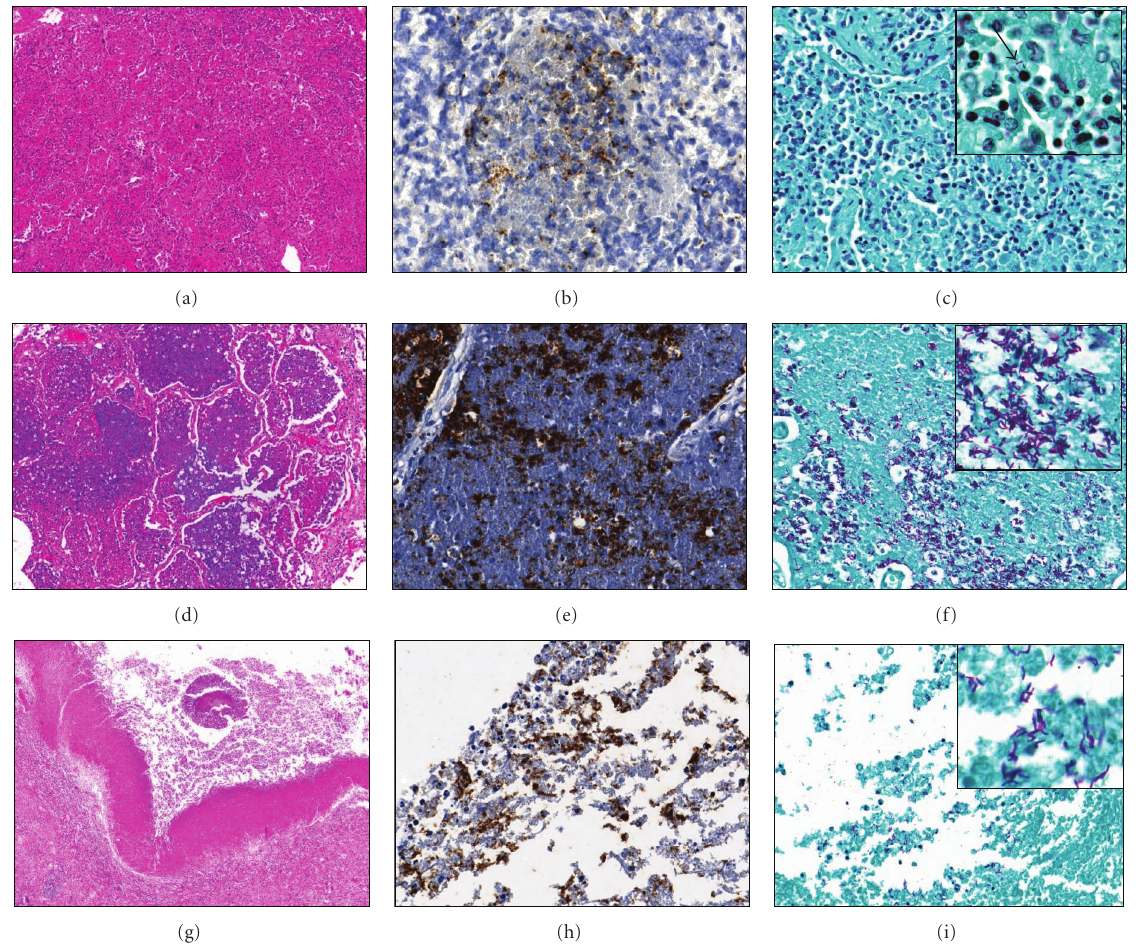
Figure 4: Comparison of immunohistochemistry (IHC) for MTB and Zhiel-Neelsen acid fast staining. Early lipid pneumonia (a)–(c). (a) H&E stain demonstrates macrophages and lymphocytes within the alveoli, 100x. (b) MTB are noted on the IHC, 400x. (c) Few AFB are observed by Zhiel-Neelsen staining, 400x. Lipid pneumonia undergoing abrupt necrosis (d)–(f). (d) Cells in alveoli undergo necrosis and have a homogenous appearance, 100x. (e) Abundant mycobacterial antigens noted on the IHC stain for MTB, 400x. (f) Numerous acid-fast bacilli are observed, 400x. Cavitary TB (g)–(i). (g) H&E stain showing a cavity with a piece of detached lung and necrotic debris, 40x. (h) The wall of the cavity is strongly positive for MTB antigens, 400x. (i) Acid-fast bacilli are found lining the cavity wall,